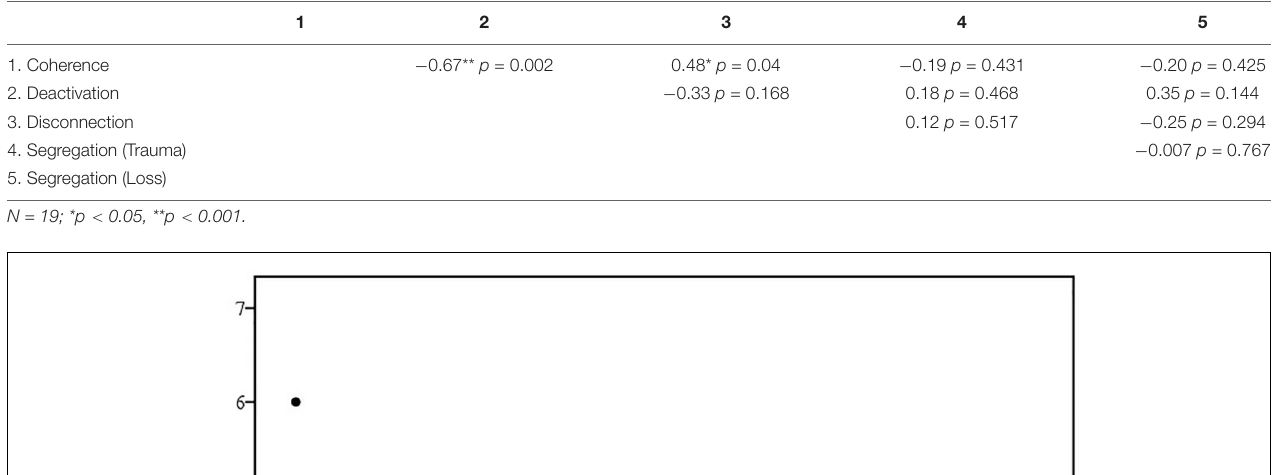
Segregation (Loss), and changes in internalising and externalising CBCL scores across treatment are displayed in Table 5 . Contrary to the hypothesis, none of the defense processes in the family discourse during Bumps in the Road appeared to be associated with change in internalising or externalising symptoms in the referred child post-treatment ( r s > 0.3 and/or p <